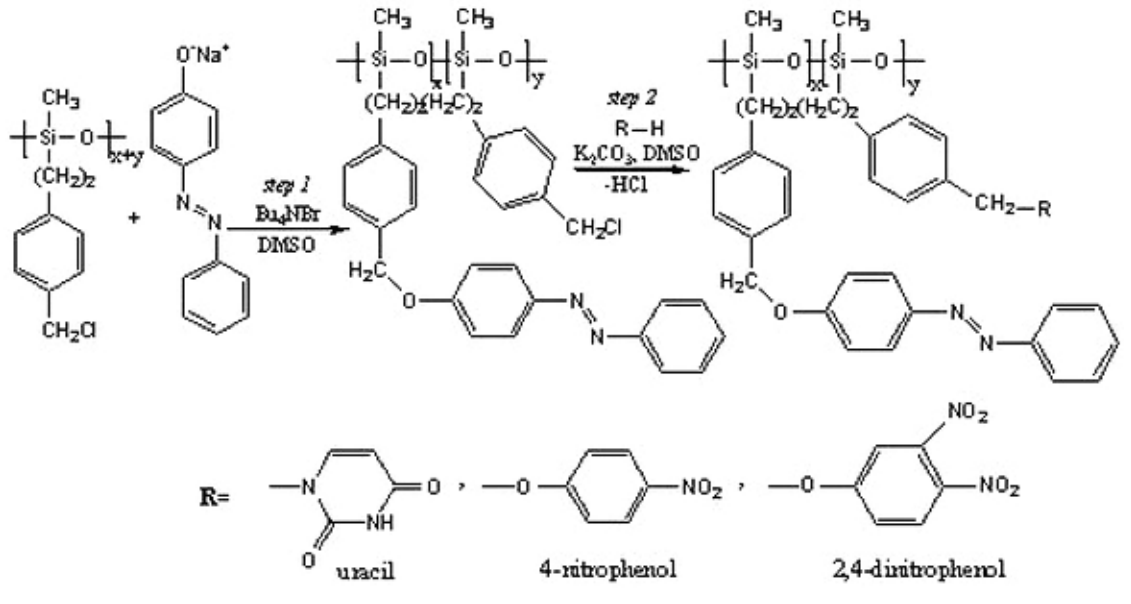
Fig. 1 Synthesis route to the azo-polysiloxanes modified with uracil or nitro-phenolic